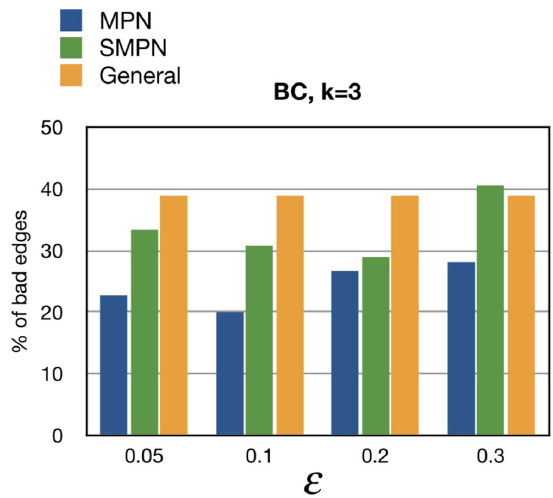
Figure 3. The percentage of bad edges for various values of e and k ~ 3 for MPN, SMPN, and General PNs for BC learned by DiProg.